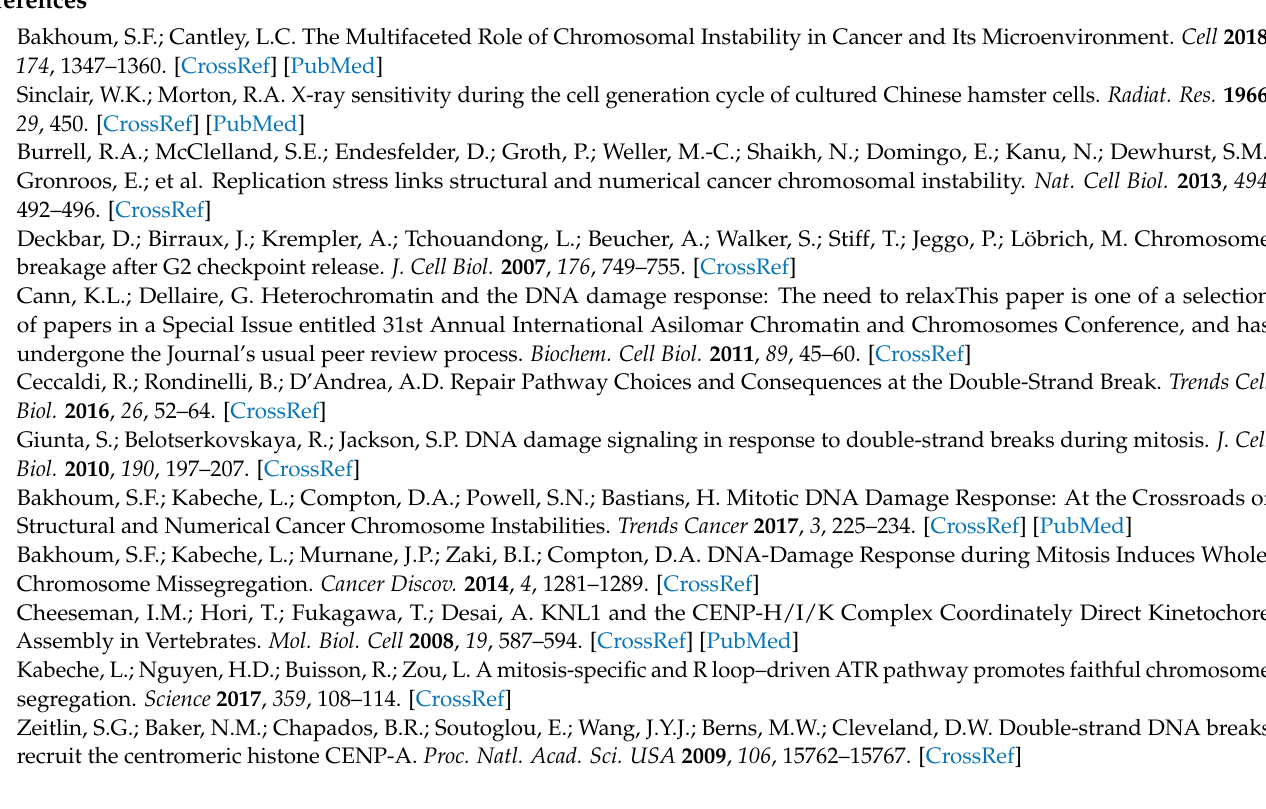
Figure S6: Loss of CENP-I results in increased RNA:DNA